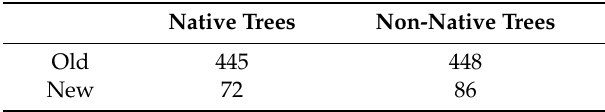
Table A4. Contingency table for test “L” (all neighbourhoods in